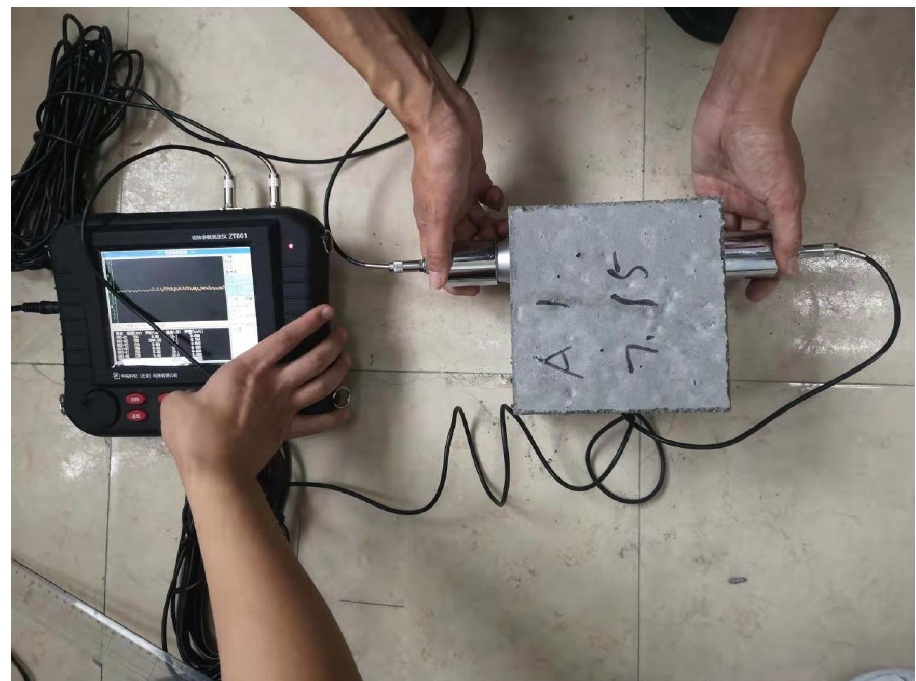
Figure 4. Pair measuring method.